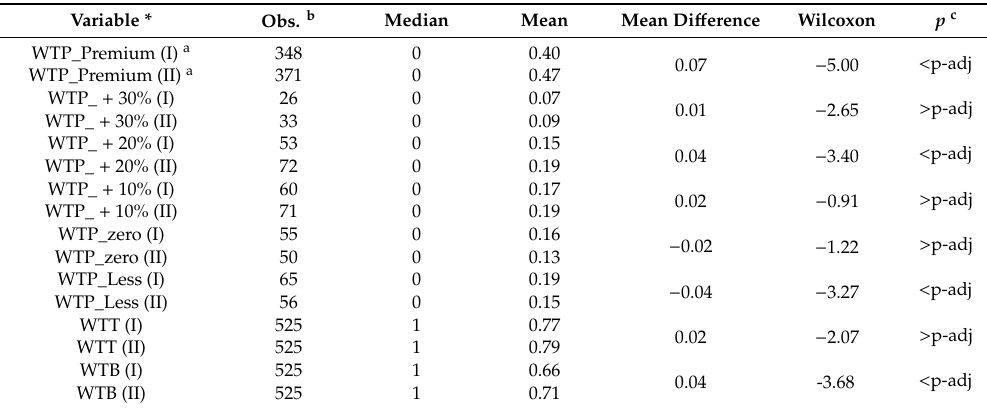
Table 4. Willingness to pay (WTP), try (WTT), and buy (WTB). Median, means, and significance of di ff erences between the level II and the level I of